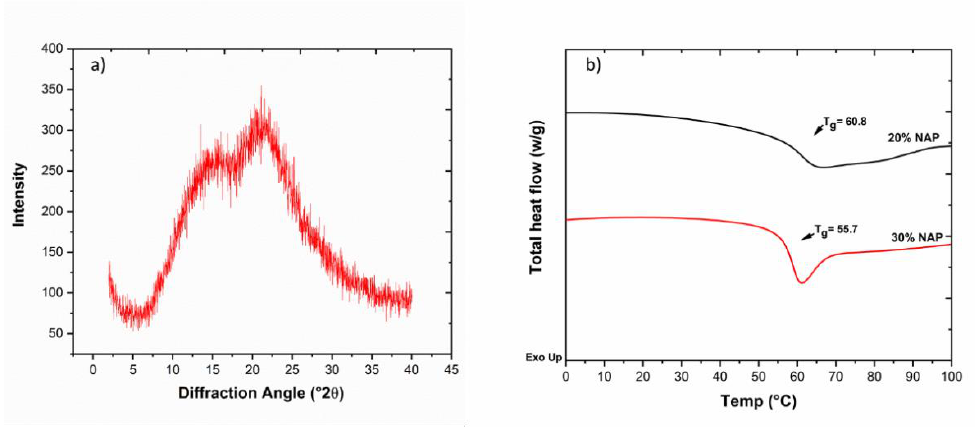
Figure 6. ( a ) Diffractogram from the 3D-printed tablets containing 30% NAP; ( b ) DSC thermo- gram of tablets containing 20% and 30%